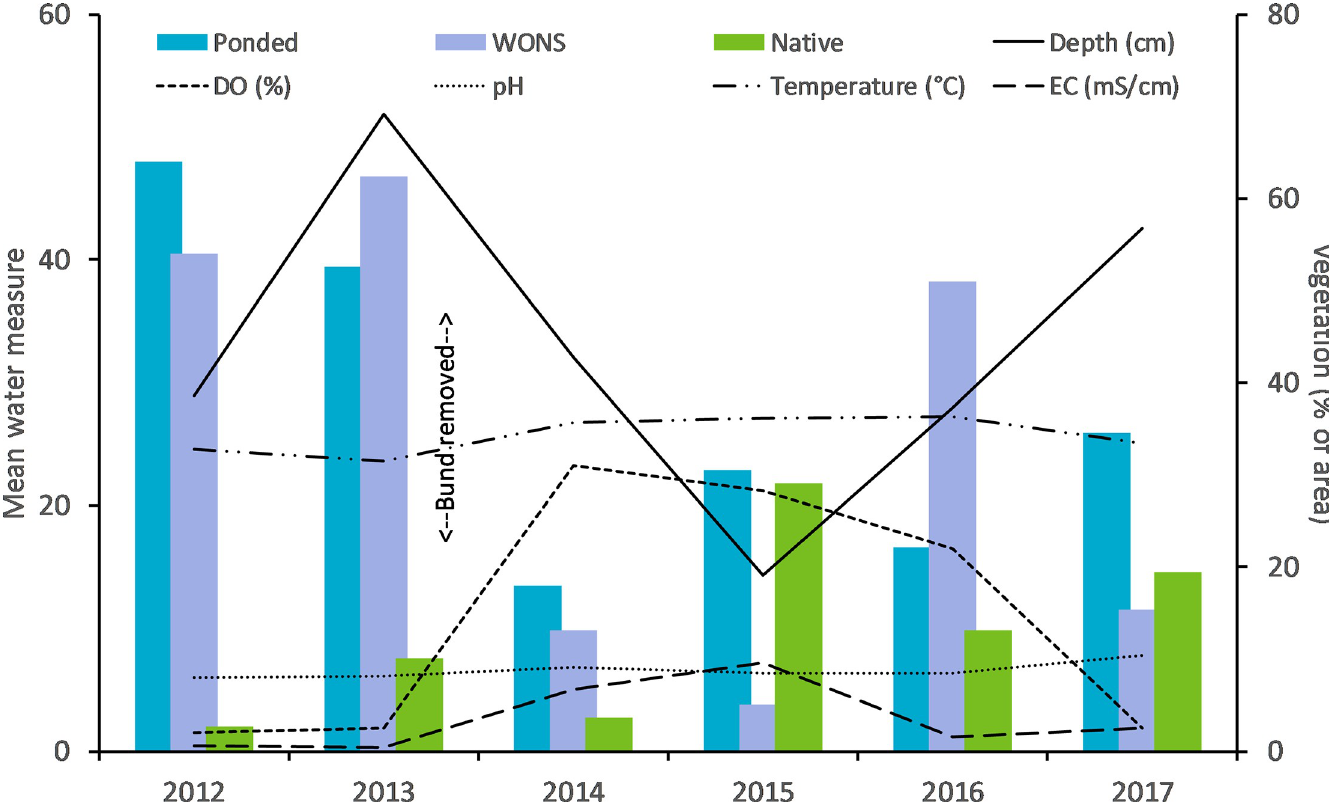
Fig 18. Yearly mean water quality and vegetation proportions. Shown are the mean water quality measures within the above bund location of the Boolgooroo wetland with vegetation grouped into weeds of national significance, Ponded pastures and native vegetation.